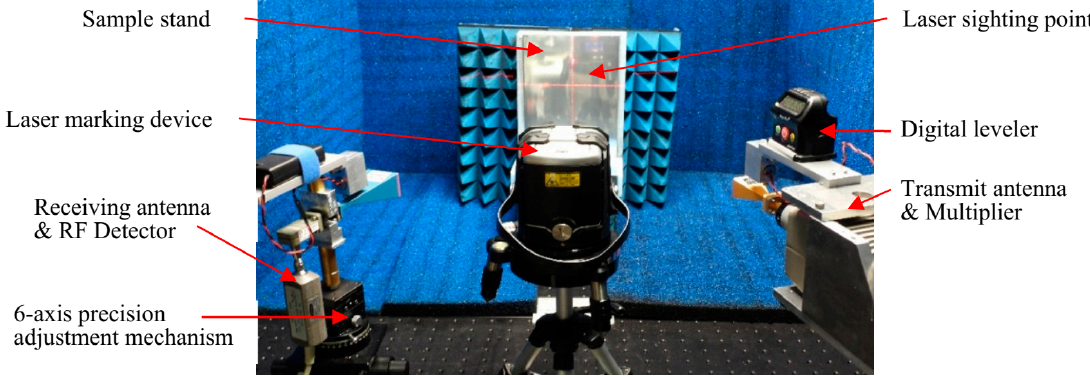
Figure 8. Outline of the installation of the antenna and sample stand, etc.